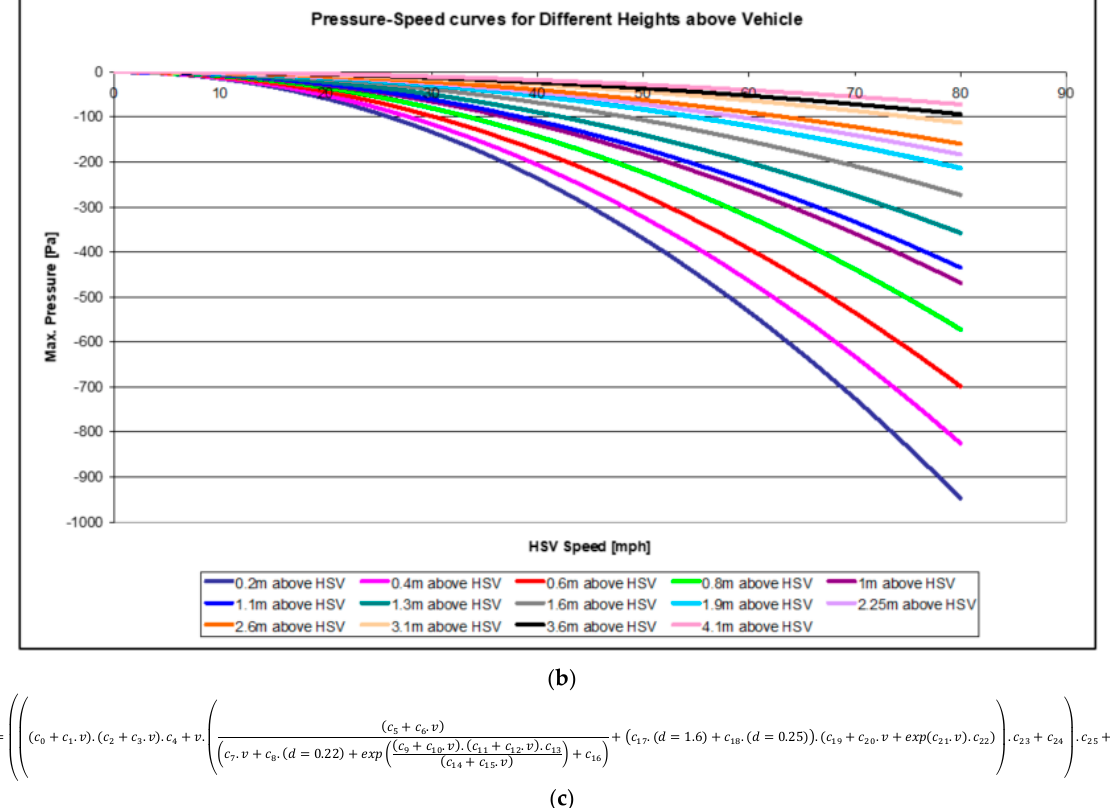
Figure 12. ( a ) Graphical representation of the calculated scatter plot for genetically-driven function and its derivation tree, ( b ) design curves for maximum exerted pressure in terms of speed and gap distance, and ( c ) resulting functional from genetical algorithm symbolic regression for maximum pressure in terms of vehicle speed v and distance gap d.